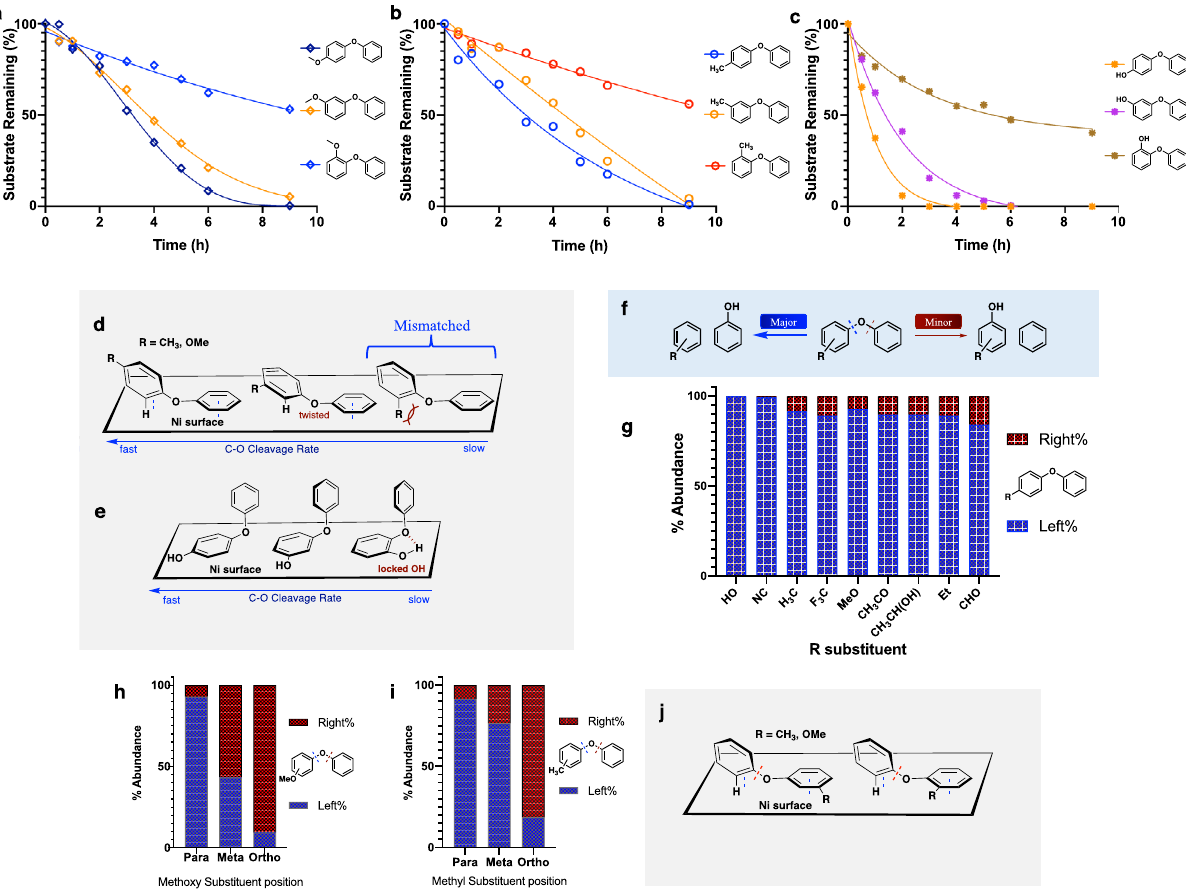
Fig. 7 Substituent positional modulation of cleavage regioselectivity. C-O bond cleavage rate comparison of DAEs with different substituents at ortho, meta, and para ring positions under standard ECH condition; 50 mA, 60 °C and pH 8 borate buffer/IPA (2:1): a diphenyl ether with a methoxy moiety b diphenyl ether with a methyl moiety c diphenyl ether with a hydroxy moiety. d – e Proposed coordination modes of para, meta and ortho-substituted diphenyl ethers. f Regioselectivity of unsymmetrical DAEs. g Regioselectivity distribution of different para-substituted diphenyl ethers. Regioselectivity distribution of para, meta and ortho-substituted structures of h methoxylated diphenyl ether i methylated diphenyl ether. For additional time courses and product analyses see supplementary Figs. 25 – 27 & 61 – 67. j Switching of binding conformation of meta and ortho-substituted